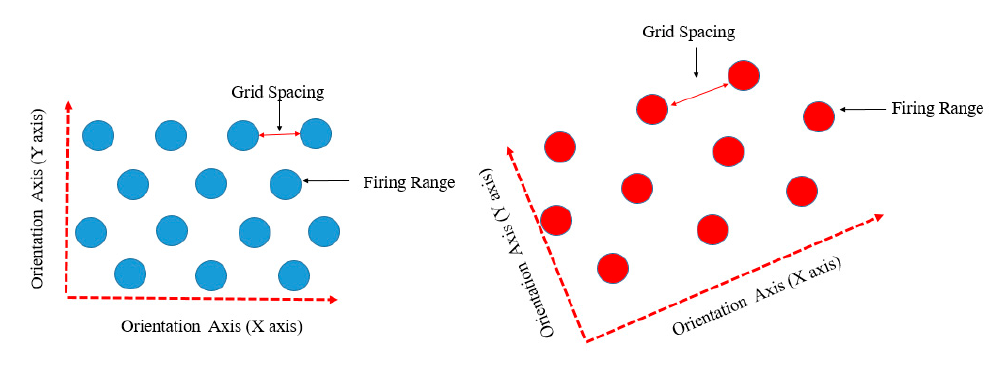
Figure 2. Grid activation patterns of different spacing and orientations.